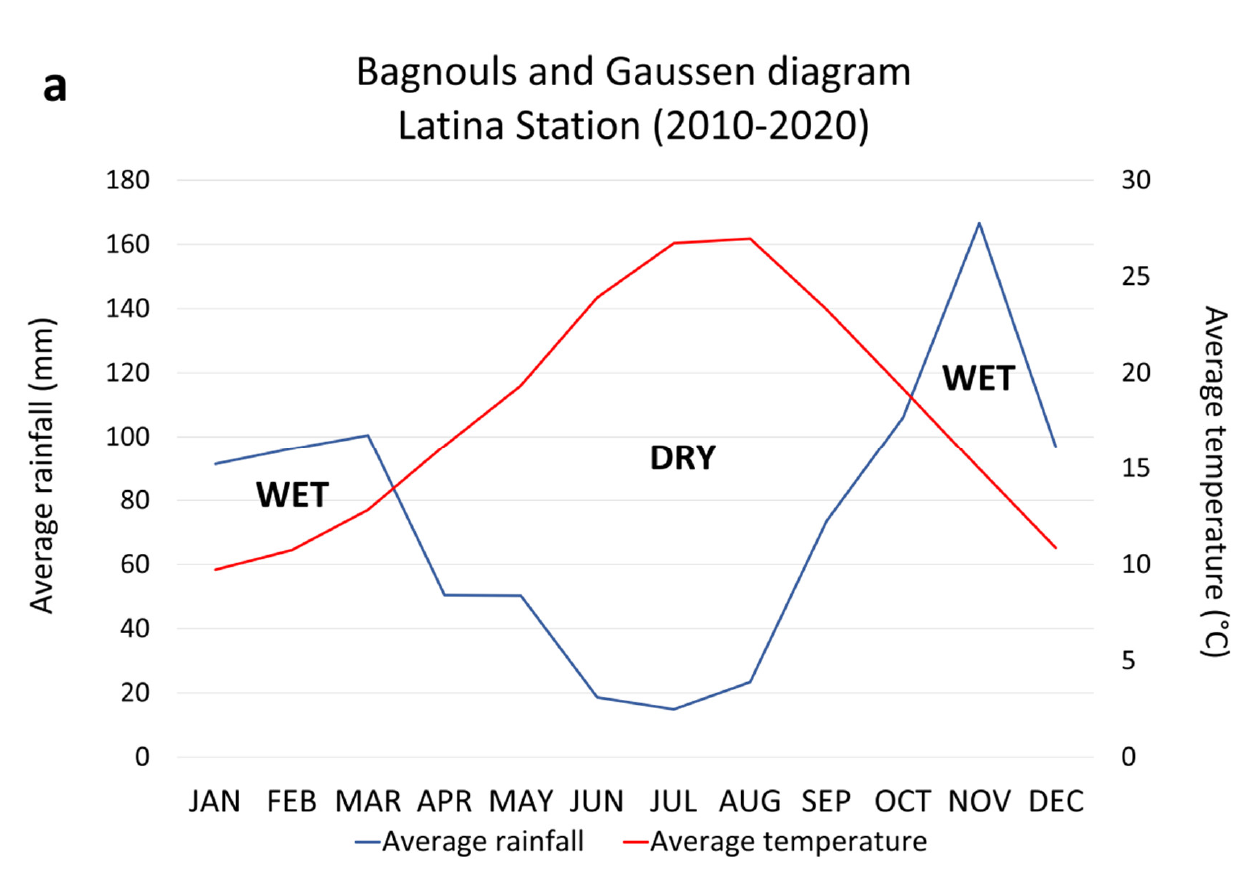
Figure 1. Study area and Green Macroareas in the Municipality of Latina.